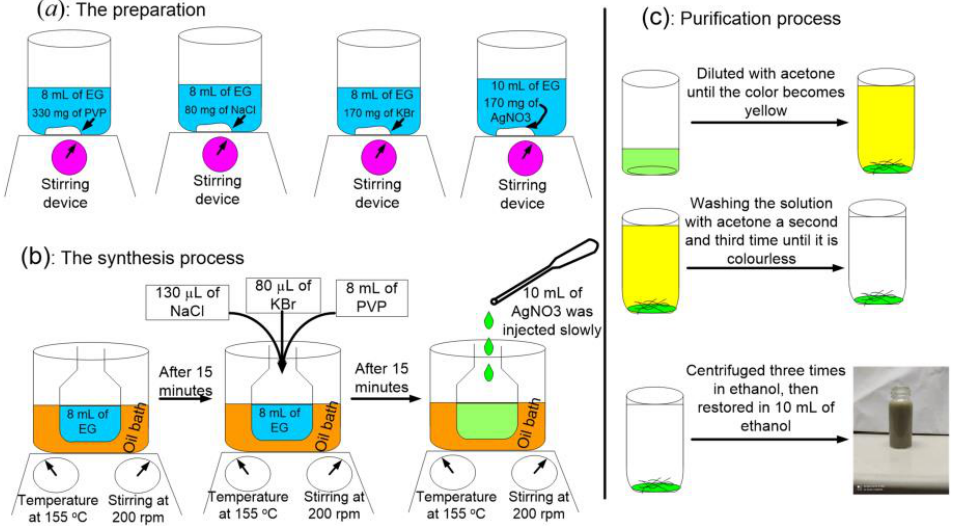
Figure 1. Schematic diagram illustrating ( a ) the preparation of precursor solutions; ( b ) synthesis protocol using the modified polyol method; and ( c ) the purification strategy used for the AgNW fabrication.